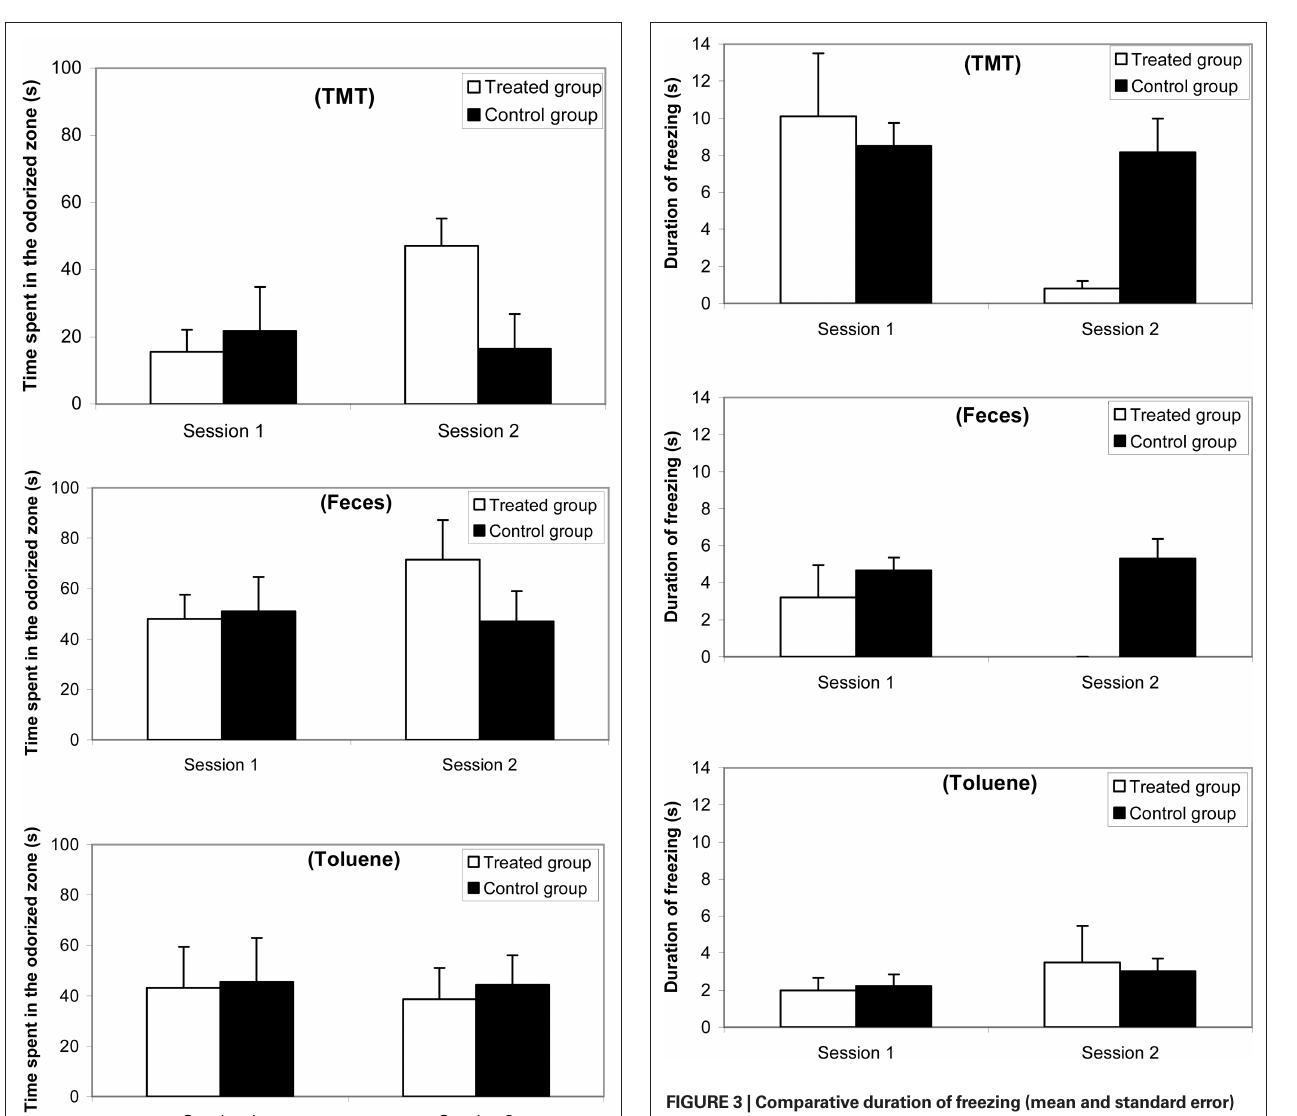
Figure 3 | Comparative duration of freezing (mean and standard error) between synthetic 10% TMT, natural fox feces, and 10% toluene odorant conditions for a female mice group ( n = 10) before (Session 1, 1 week before treatment) and after (Session 2, 3 days after treatment) ZnSO intranasal perfusion and for a control female mice group ( n = 10).